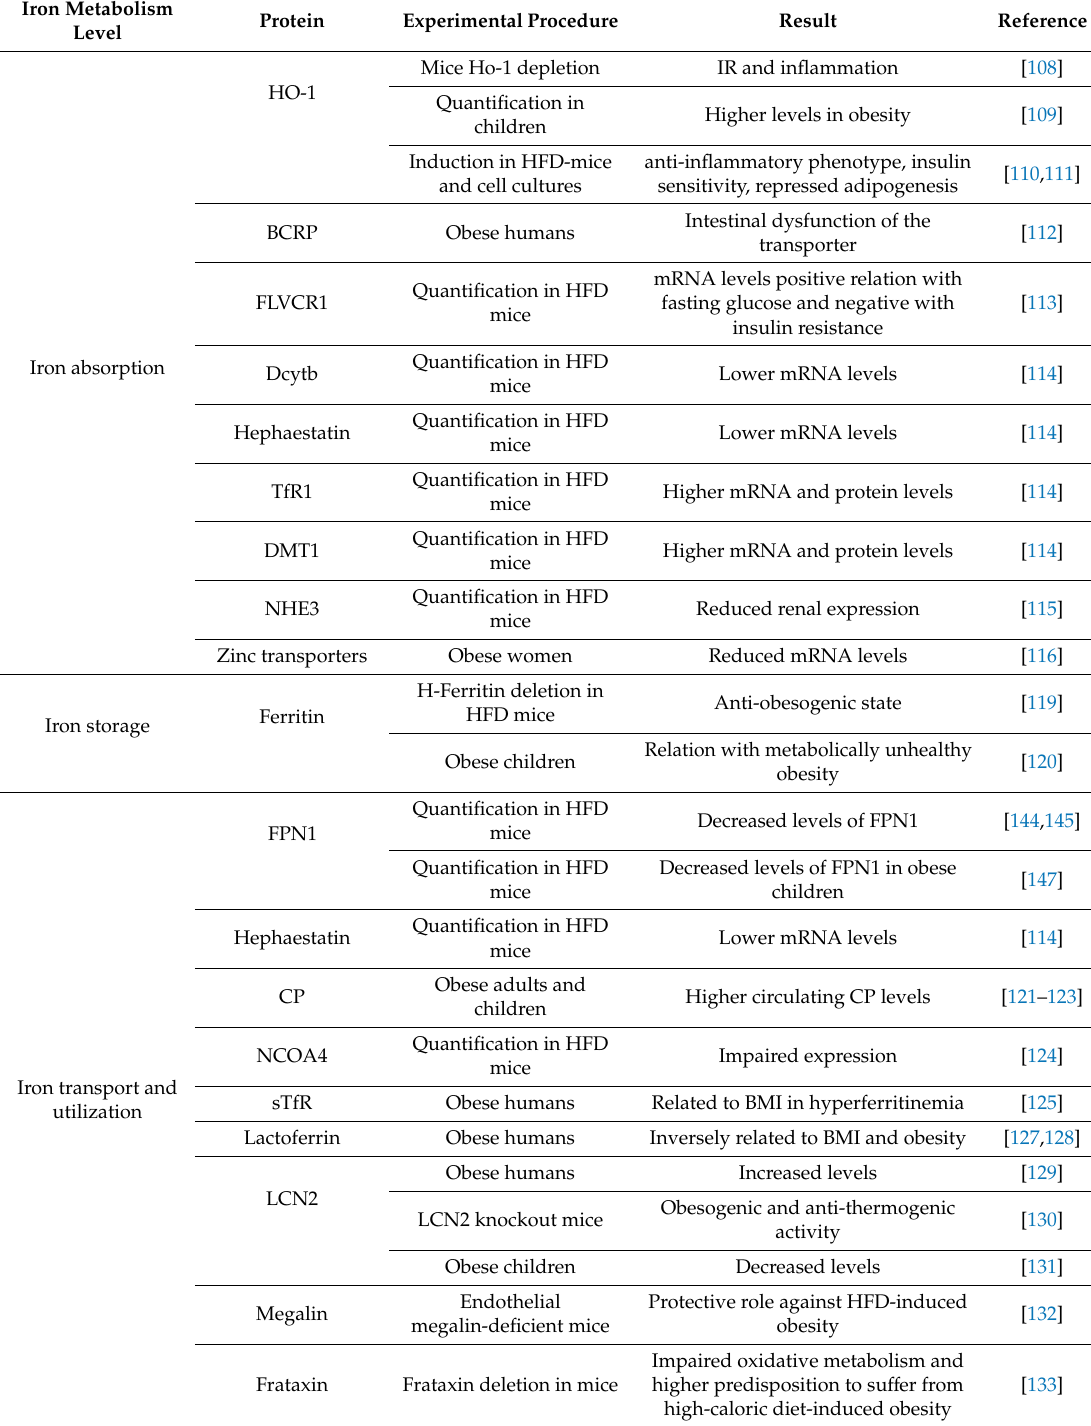
Table 1. Iron metabolism disturbances described in